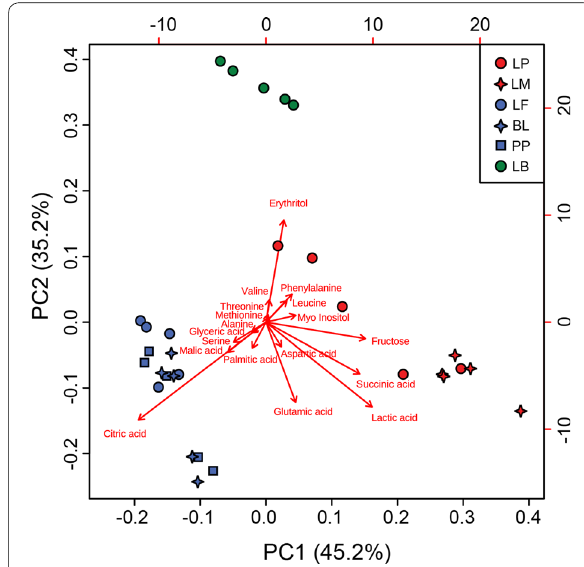
Fig. 3 PCA biplot derived from metabolites identified from tomato samples fermented with different LAB strains. Arrows represent metabolites responsible for the divergence between tomatoes fermented with different LAB strains. LP Lactobacillus plantarum ; LM Leuconostoc mesenteroid ; LF Lactobacillus fermentum ; BL Bifidobacterium longum ; PP Pediococcus pentosaceus ; LB Lactobacillus